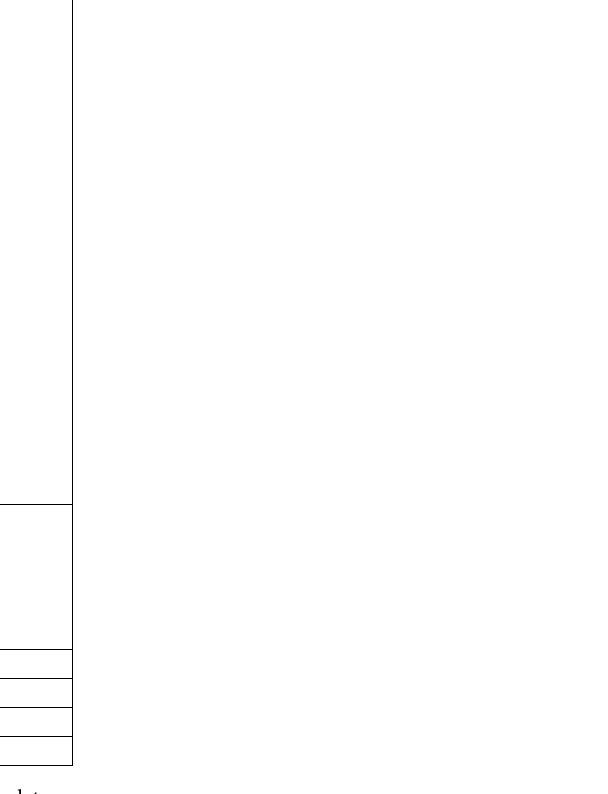
Table 2. PFGE profiles of 67 M. kansasii